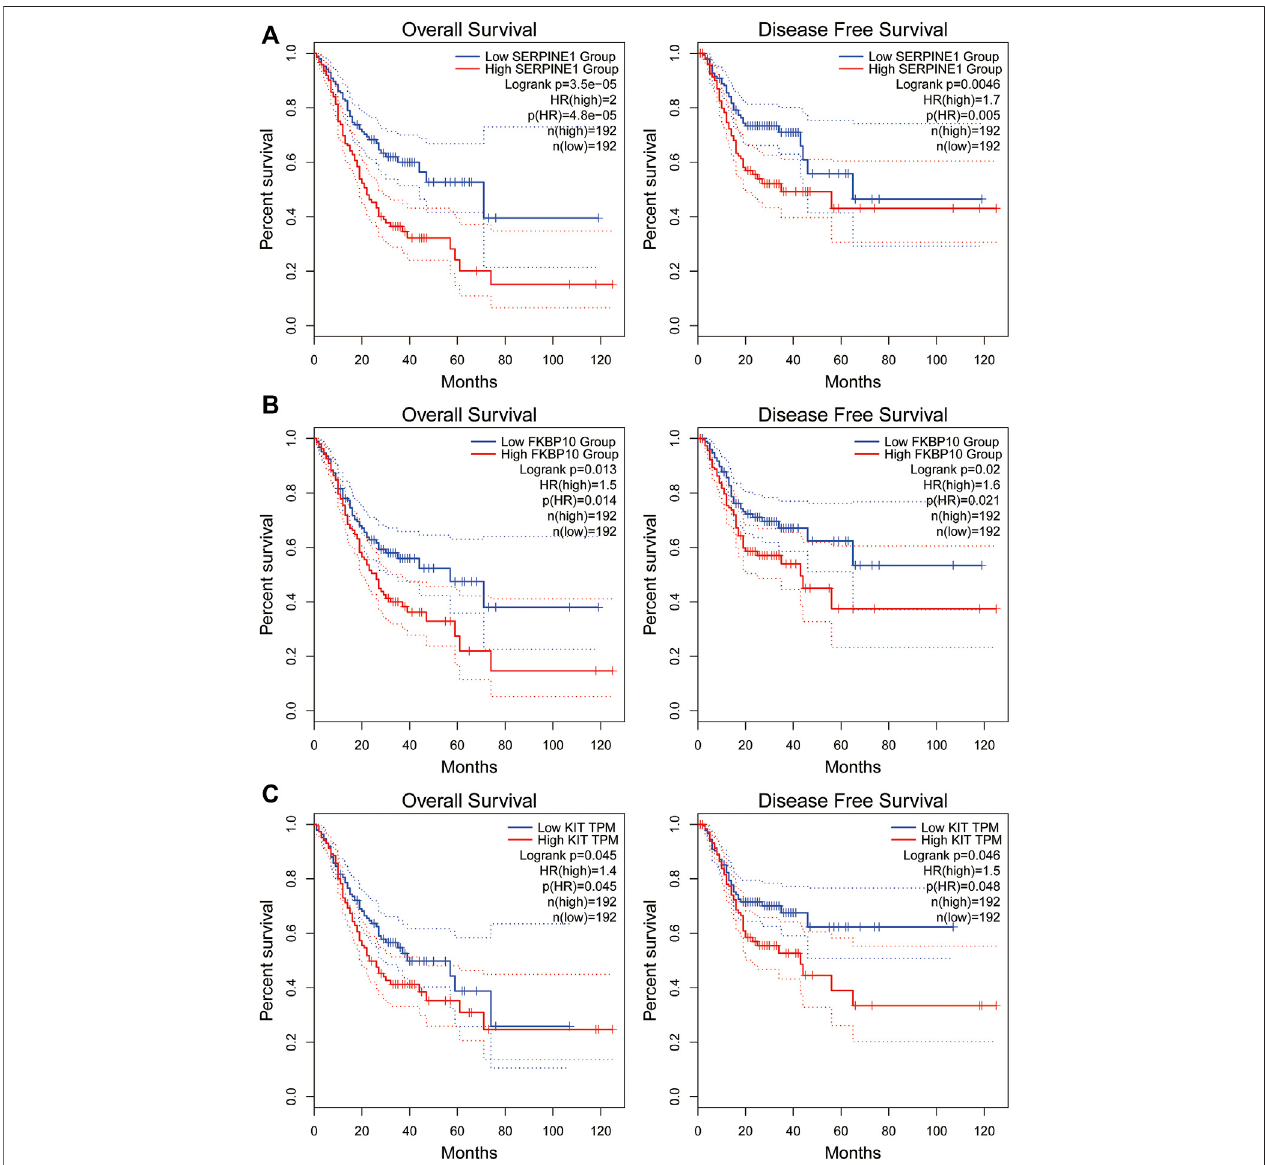
FIGURE3| Overallsurvivalanddisease-freesurvivalanalysisofSTAD/COVID-19-relatedgenesinGEPIAdatasets. (A) :SERPINE1, (B) :FKBP10, (C) :KIT. P < 0.05 was considered statistically signi fi cant.